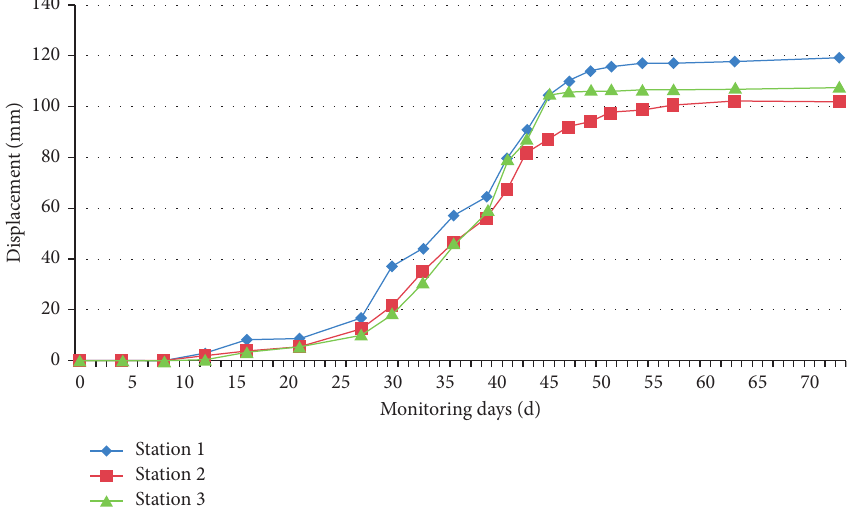
Figure 18: The displacement monitor of sides.